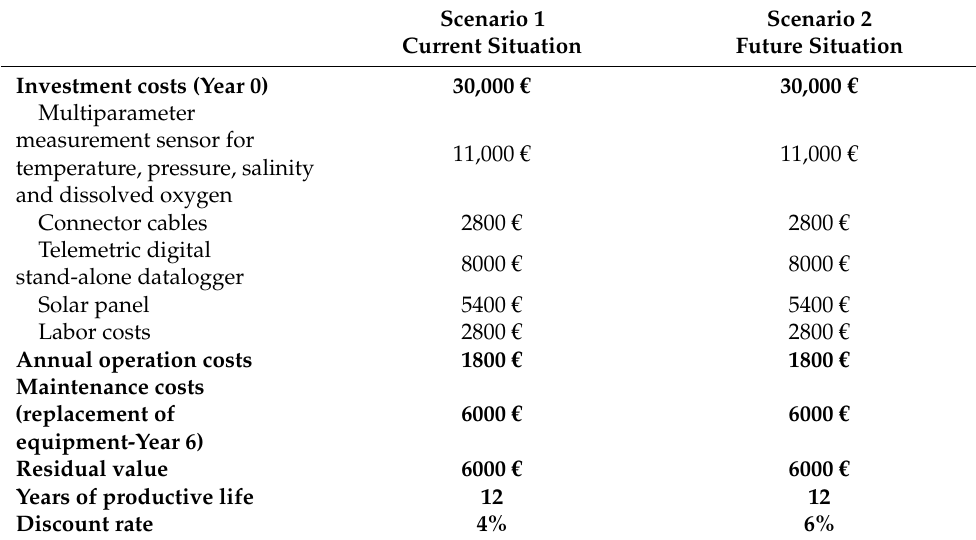
Table 3. Cost–benefit analysis data and assumptions.